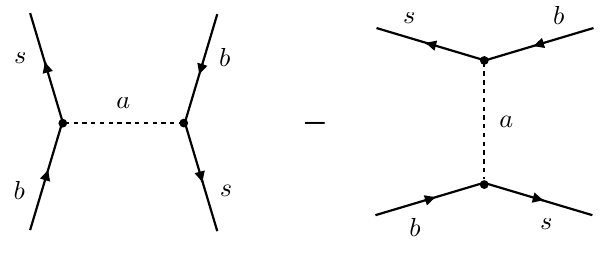
¯ B s mixing. The relative signs between a (cid:28) m b